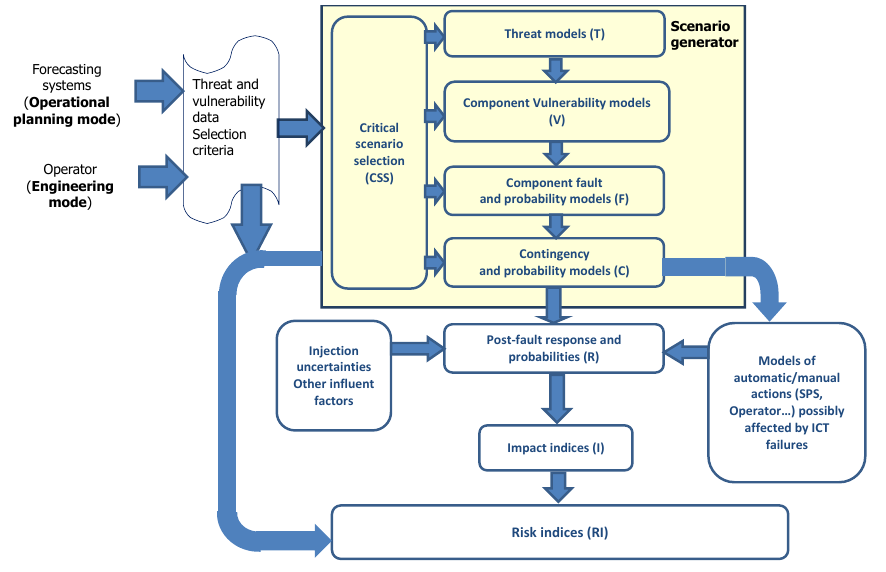
Figure 3. Workflow of the proposed tool [10].